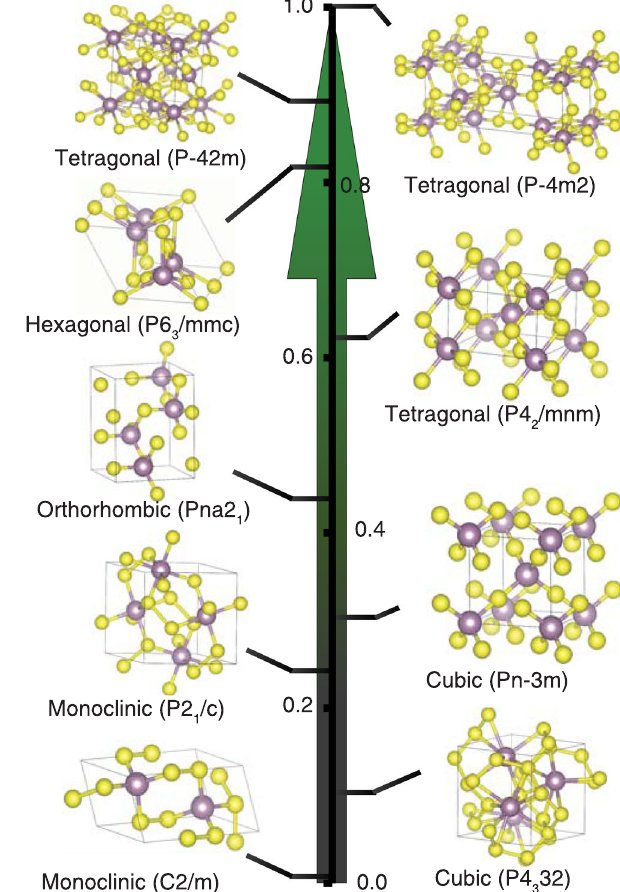
Fig. 7 The synthesizability likelihood prediction of different polymorphs of molybdenum disul fi de. Selected crystal structures of MoS 2 are sorted from bottom to top based on their synthesizability likelihood, predicted by the CAE + MLP classi fi er. The crystal type followed by the space group number is shown for each minor structural variations. This arises from the architecture of their model, in which crystal information is represented by multi- perspective atomic fi ngerprints, which serve as descriptors in a print can encode the local topology in the vicinity of each site by translating the high-dimensional position-composition space into a lower dimension radial distance space, which can lead to information loss. Our model surpasses this limitation by com- bining a more global structural and chemical pattern representa- tion using voxel-wise images. Additionally, feature learning through the convolutional encoder used in this study is a suitable design because of the inherent long-range transnational symmetry of crystals.